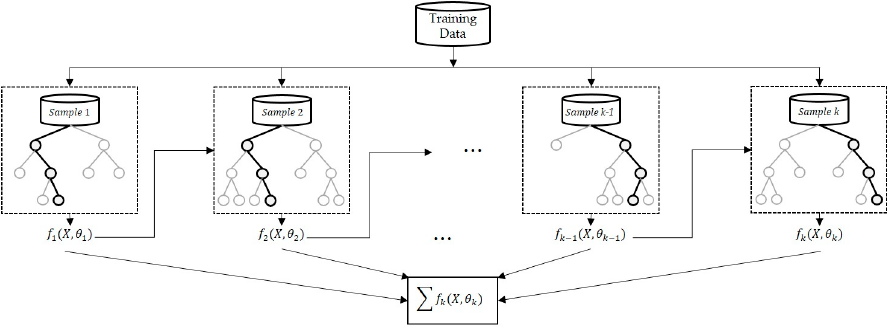
Figure 6. Schematic of the XGBoost method.